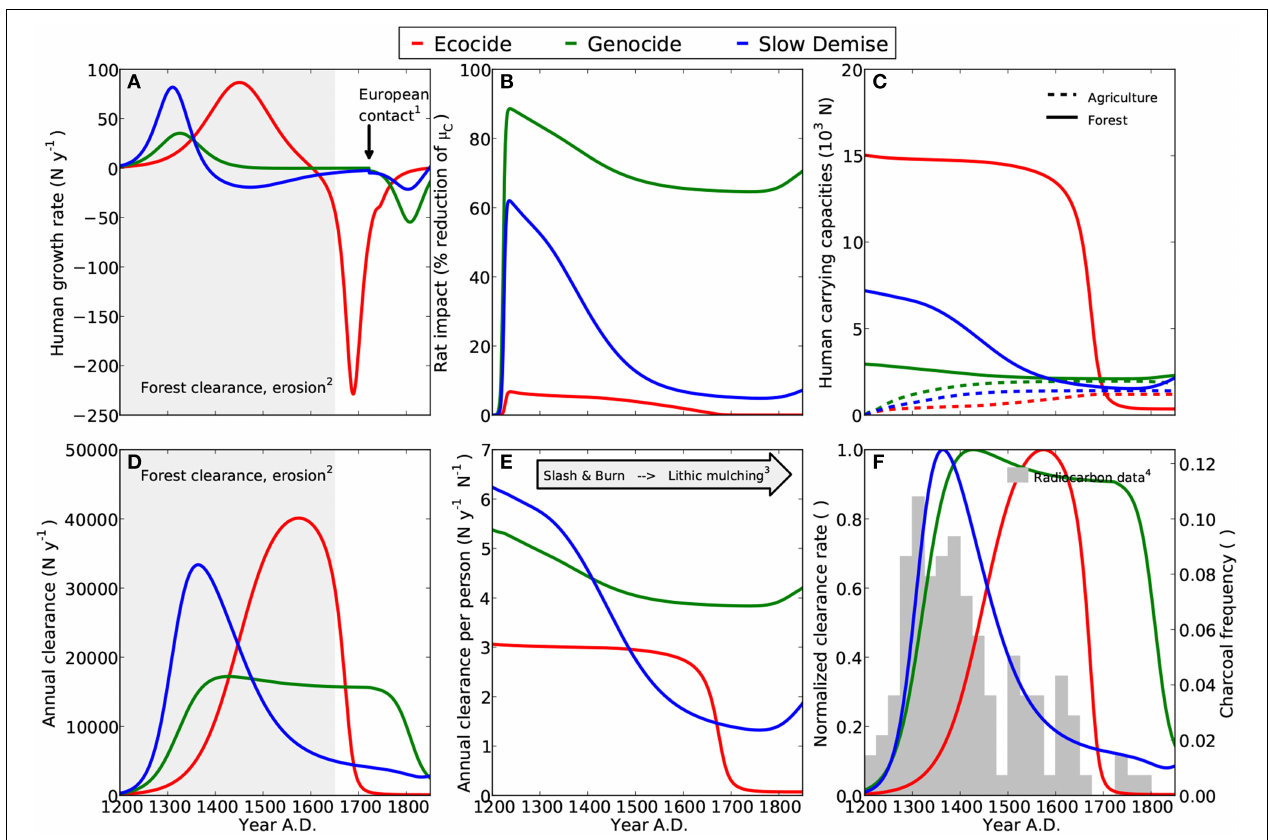
FIGURE 2 | Diagnostics for three model scenarios ecocide (red), genocide (green), and slow demise (blue). Small numbers indicate references to archaeological evidence. (A) Annual growth rates of human population, (1) First European contact in 1722AD (González and Roggeveen, 1908; Heyerdahl and Ferdon, 1961), (2) Evidence for deforestation completed around 1650AD (Orliac, 2000; Hunt, 2007; Mann et al., 2008; Mieth and Bork, 2010). (B) Adverse effect of rats on the growth rate of palm trees; here expressed as a percentage reduction of the rat-free tree growth rate. (C) Carrying capacities for humans in